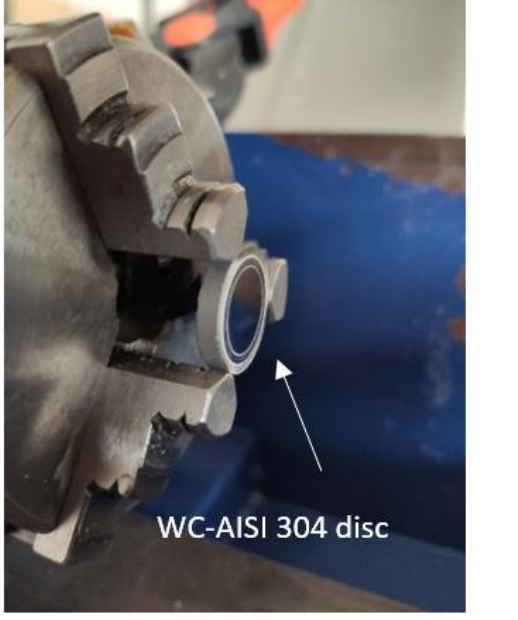
Figure 5. Diagram of the Pin-on-Disc test method [33].